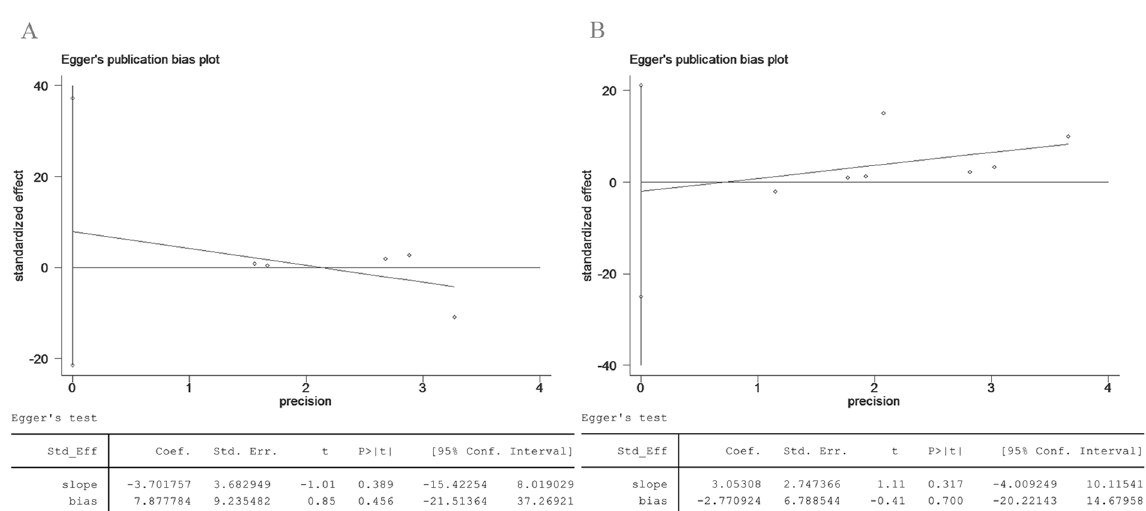
Figure 8. Egger test for compensatory sweating, suggesting no publication bias in the pooled analysis. ( A ) T2 vs. T3 group and ( B ) T3 vs. T4